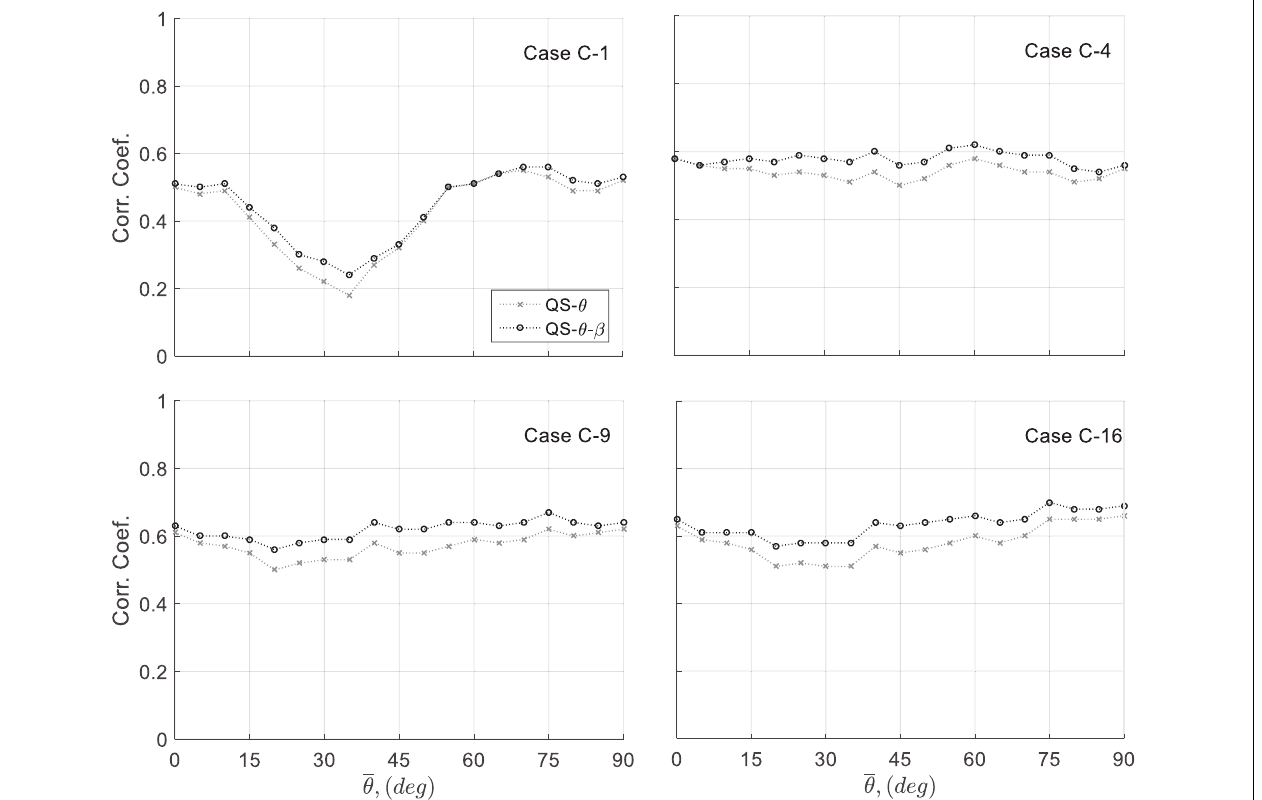
FIGURE 10 | Zero-time-lag correlation coefficient between measured and QS-predicted C p,t for cases C-1, C-4, C-9, and C-16 .